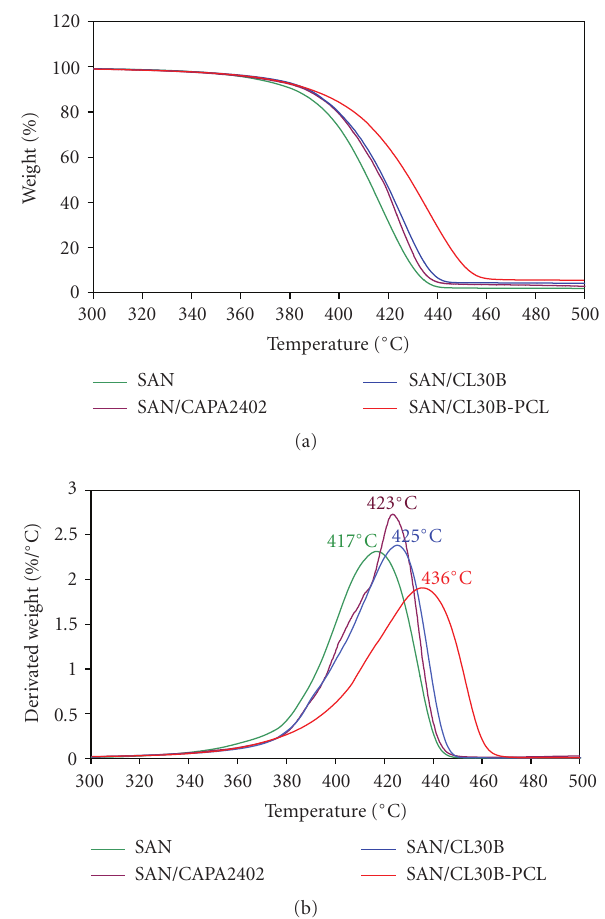
Figure 3: Thermogravimetric analysis curves of SAN, SAN/CAPA 2402, SAN/CL30B and SAN/CL30B-PCL with 3 wt% of inorganics in air, at 20 ◦ C/min.